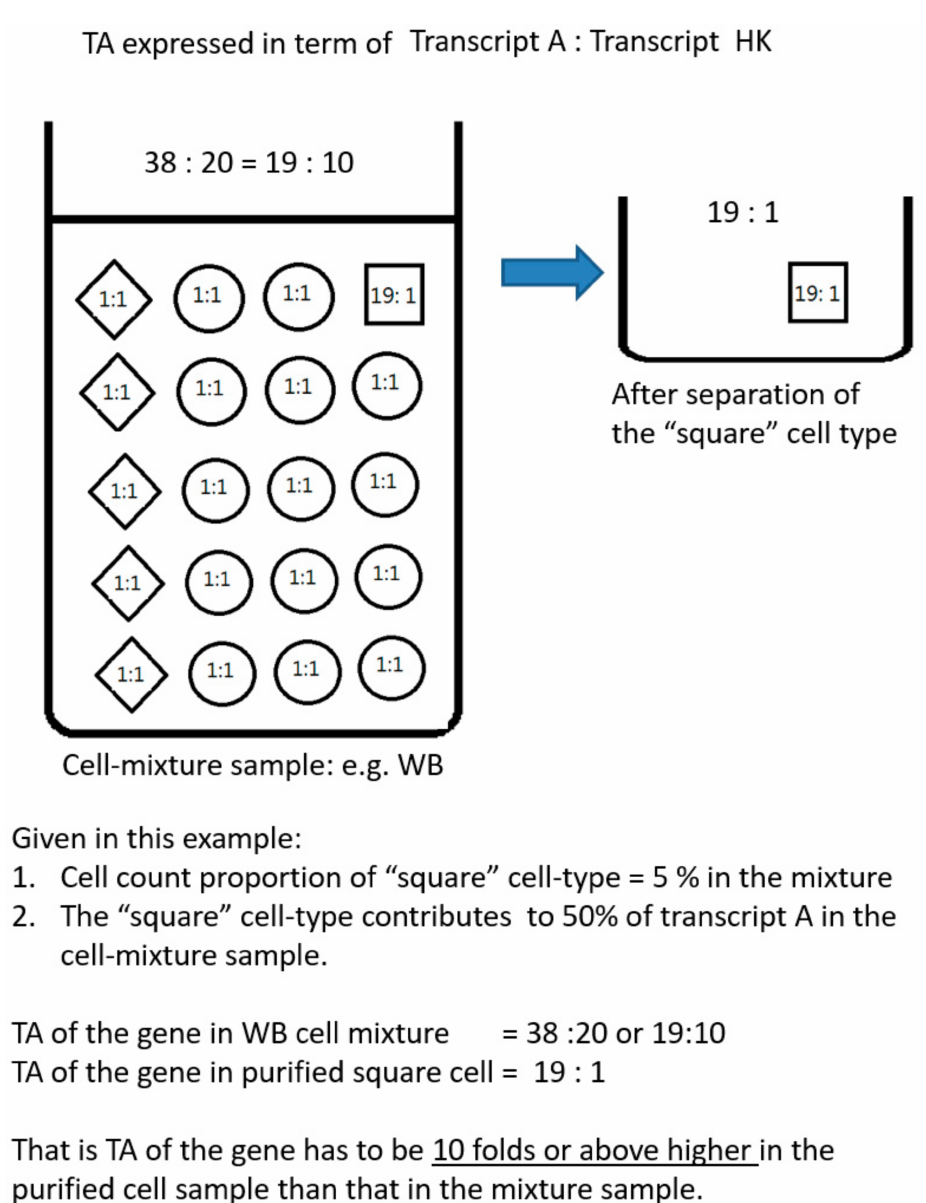
Figure 2. A theoretical model of defining B lymphocyte (represented by square symbols) informative genes in a WB sample (with three different cell-types, symbolized as square, circle, and rhomboid). A pre-defined proportional cell count of 5% is given as the proportion of B lymphocyte in WB. When TA of a gene was measured both in the WB and purified B lymphocyte samples, B lymphocyte informative genes as we defined them would have at least a 10-fold higher expression in the purified cell sample (purified B cells) than the cell-mixture sample (WB). Measurement of TA is based on a commonly used normalization approach by using a conventional housekeeping (HK) gene. (see also reference